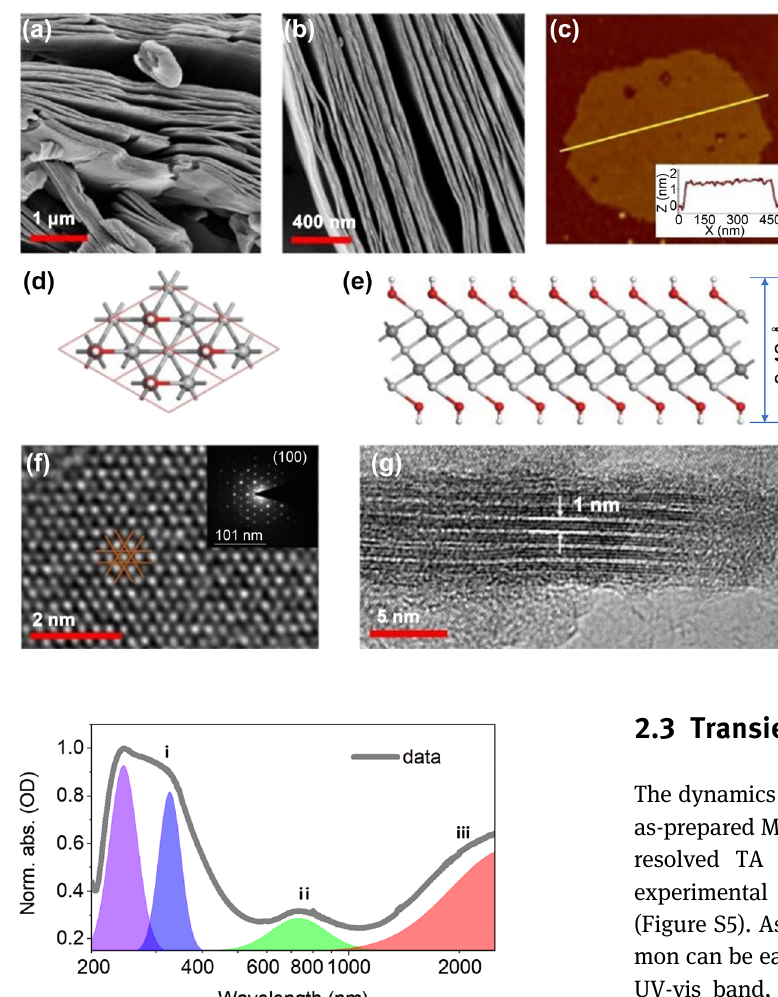
Figure 2: Steady-state optical response of the as-prepared Ti 3 C 2 T x MXene fi lm by UV-vis-IR spectroscopy, exhibiting wavelength- dependent